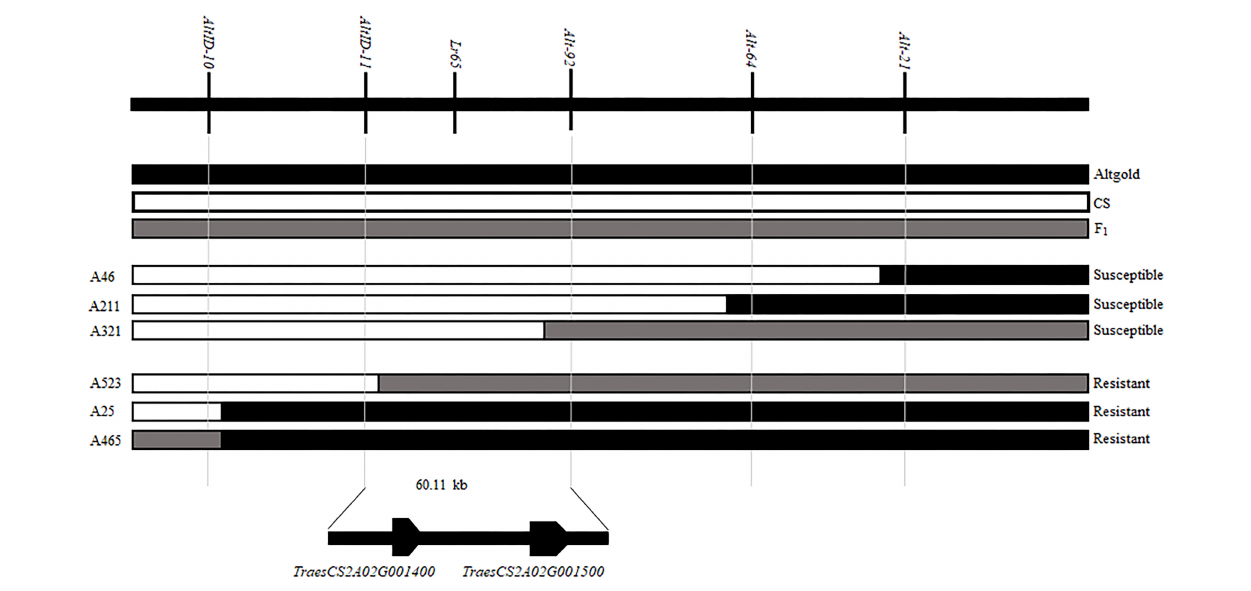
FIGURE 3 | Fine mapping of Lr65 and two annotated genes in the target interval on the Chinese spring reference genome. The phenotypes and genotypes of six F 2 recombinants are displayed. The code and phenotype of each individual were put on the left and right sides, respectively. Black, white and gray blocks represent the genomic regions of Altgold, CS, and heterozygotes,